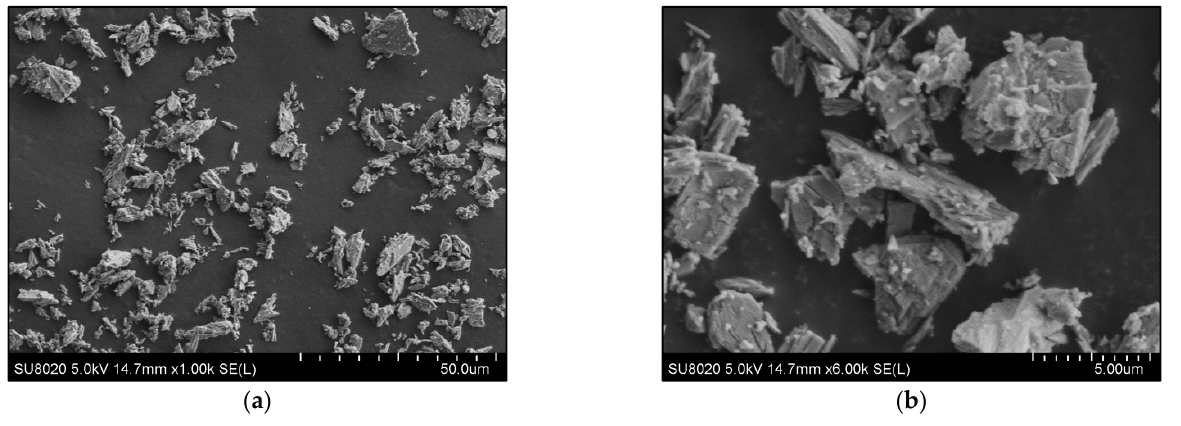
Figure 1. ( a , b ). SEM micrographs (SE mode) at different magnifications of CS AII